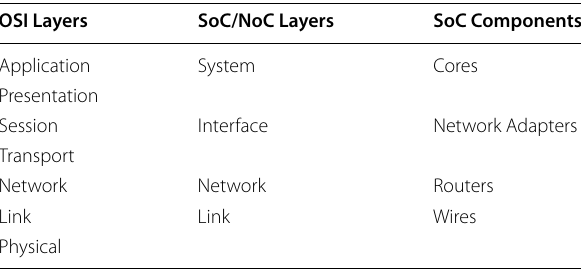
Table 1 Network components and layers OSI